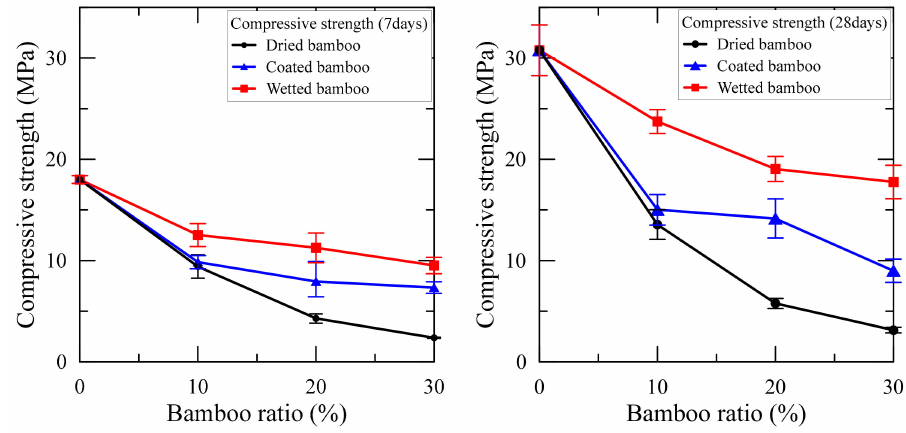
Figure 4. Comparison of the compressive